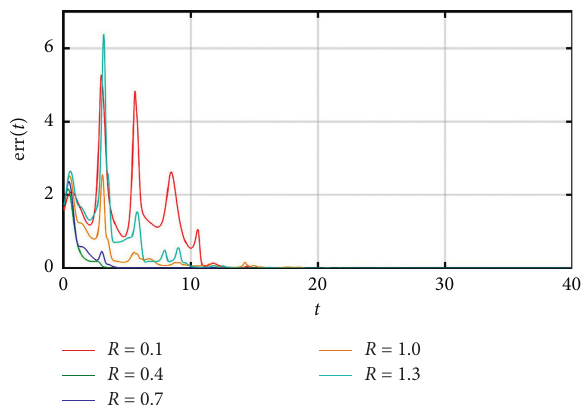
Figure 13: Variation of the absolute error err( t ) with different R